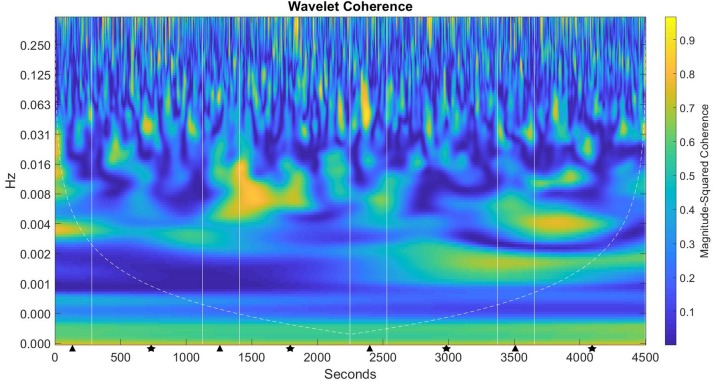
Magnitude-squared coherence plot for the NOCM group. The left axis is the frequency of coherent activity in Hz; the bottom axis is time (s). Straight lines denote task cycles with decision (triangle) – monitoring (star), shaded contours represent areas of coherent activity of greater than 95% confidence.